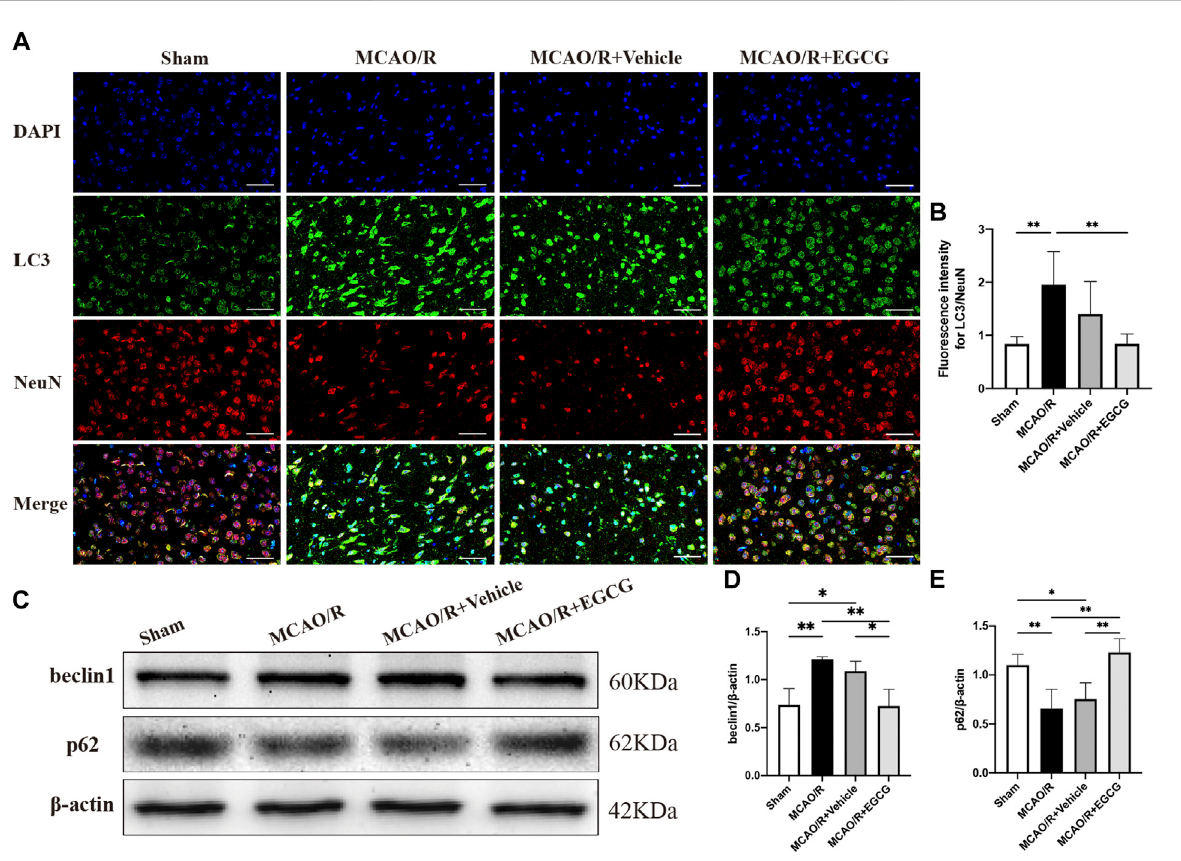
FIGURE 2 EGCG inhibited middle cerebral artery occlusion/reperfusion (MCAO/R)-induced autophagy. (A,B) The expression of LC3 was detected by immuno fl uorescent staining assay. Data were shown in the cortical penumbra area from the ipsilateral side of surgery on post-surgery day (PSD)